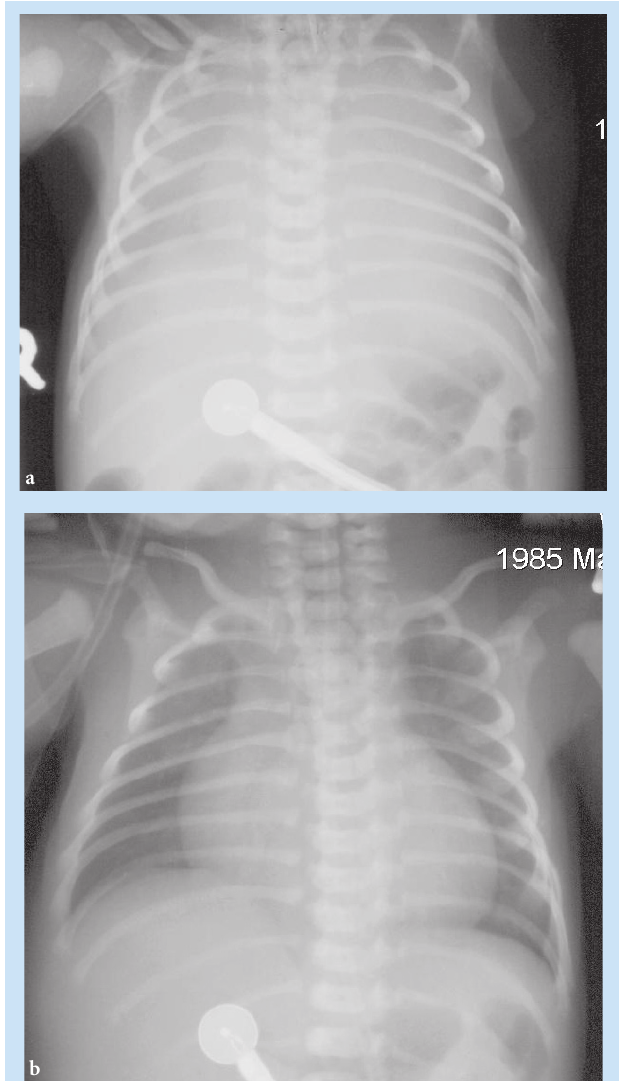
Fig. 18 (a) and (b). Transient tachypnoea of the newborn. Clearing of the bilateral airspace disease at 24 hours.